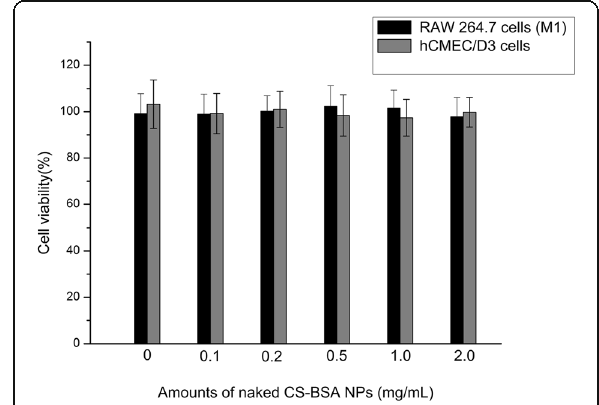
Fig. 3 Viability of RAW 264.7 cells (M1) and hCMEC/D3 cells after incubation with different amounts of naked CS-BSA NPs for